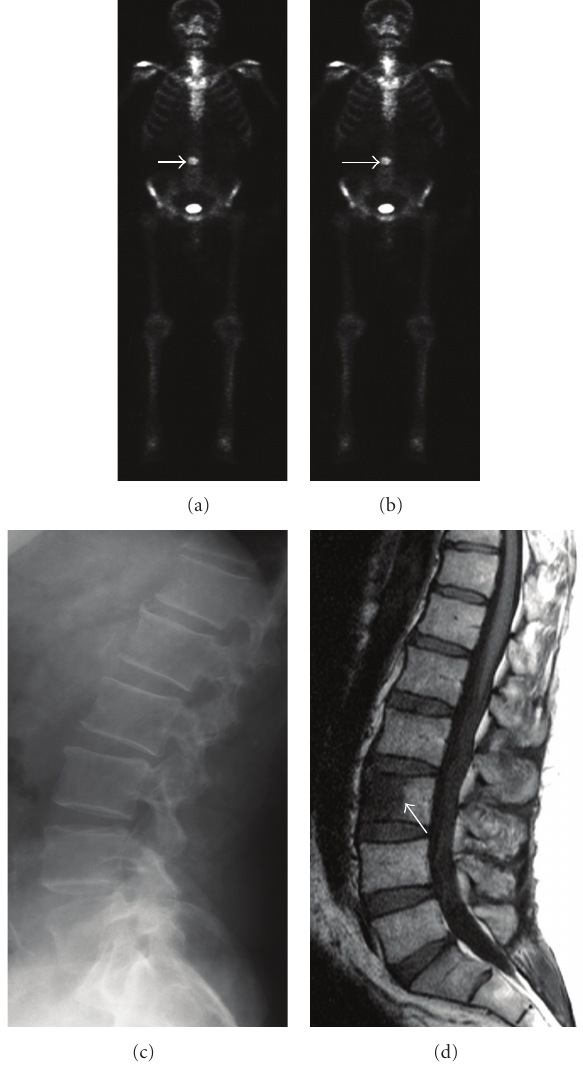
Figure 1: Example of a 55 years old patient diagnosed with high- risk localized disease. 99m Tc bone scan shows an area of uptake in the body of the 3rd lumbar vertebra ((a) and (b)). Confirmatory X-ray is read as normal (c) although MRI of the axial skeleton (T1 sequence, (d)) shows a large focal area of malignant replacement of the bone